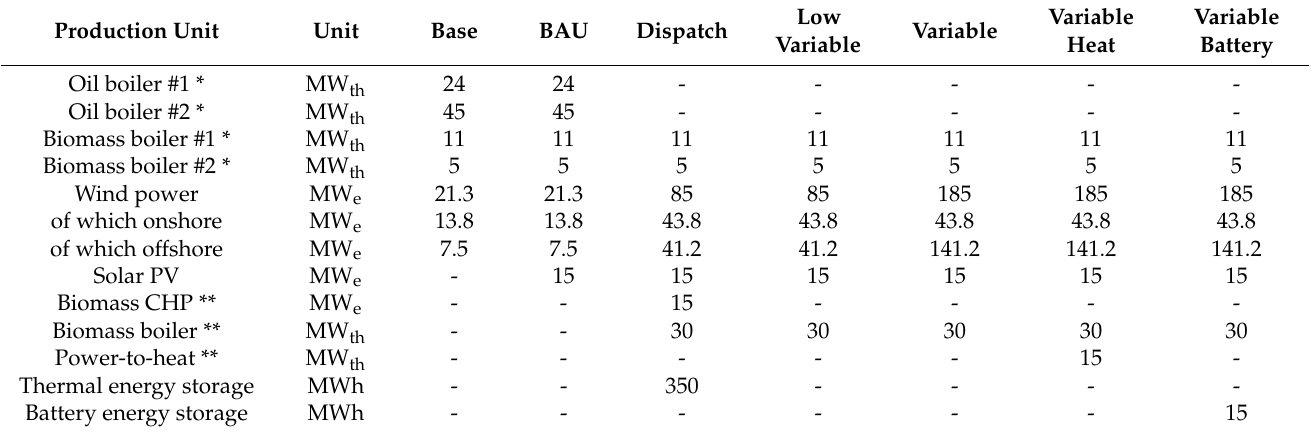
Table 1. Summary of the production and storage unit capacities in the simulated scenarios. The existing dispatchable units are marked with an asterisk (*). For the technologies marked with two asterisks (**), the capacity is optimized using the shown value as the maximum